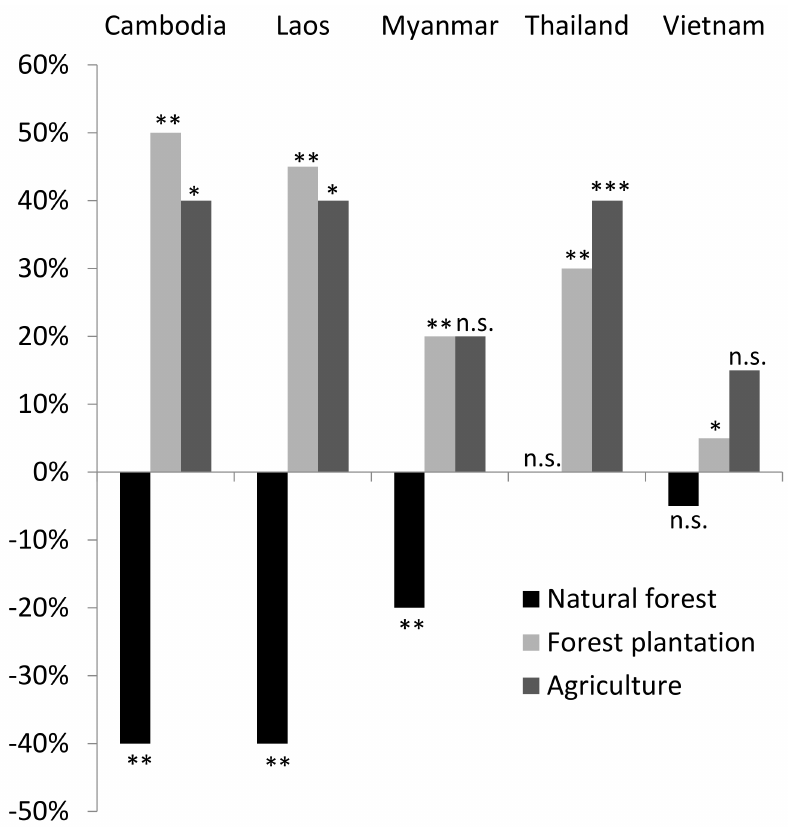
Figure 3. Expected development of major biomass resources within 25 years in the ACMECS countries. A positive value indicates an increase relative to today’s values, whereas negative values indicate a decrease, relative to the current amounts sourced from the respective categories. Statistical significance is presented as n.s. = not significant, * = p < 0.05, ** = p < 0.01, *** = p < 0.001 using the Friedman test statistics for related samples, and indicates the coherence of individual answers. Data source: post workshop survey, authors’ compilation